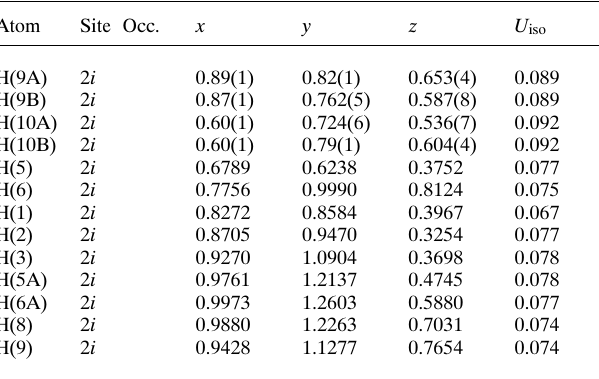
Table 2. Atomic coordinates and displacement parameters (in Å 2 ) . Atom